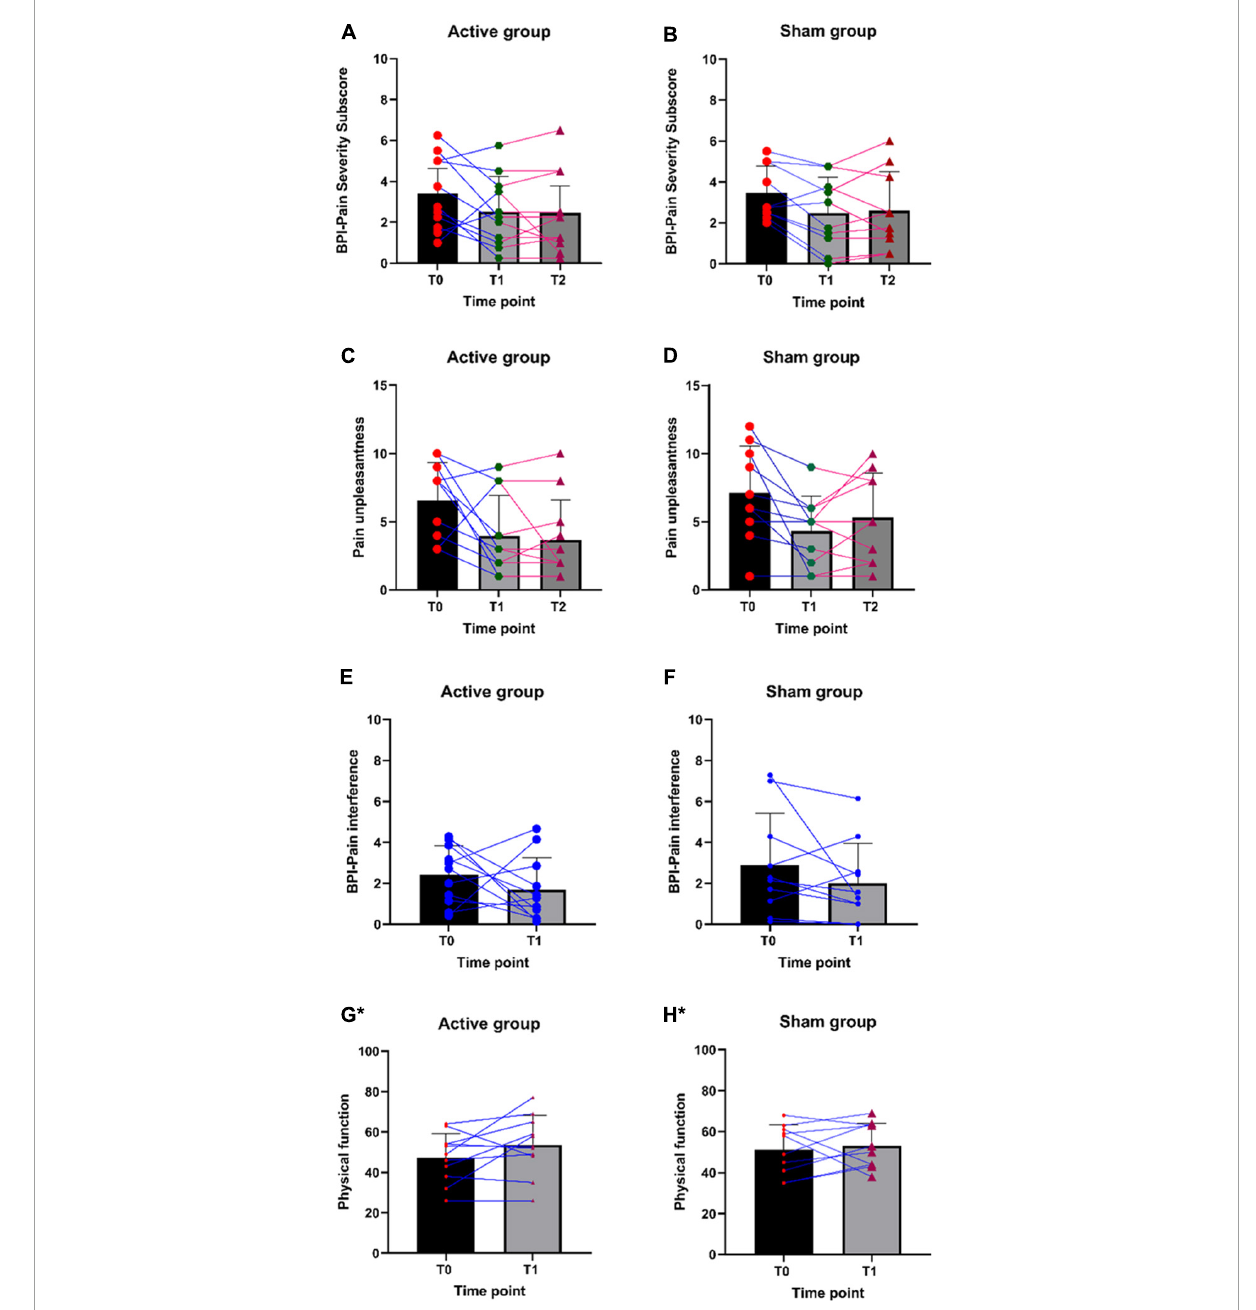
FIGURE5 (A–H) Individual participant data for pain severity, pain unpleasantness, pain interference, and physical function scores. *Higher the score, the higher the physical function.